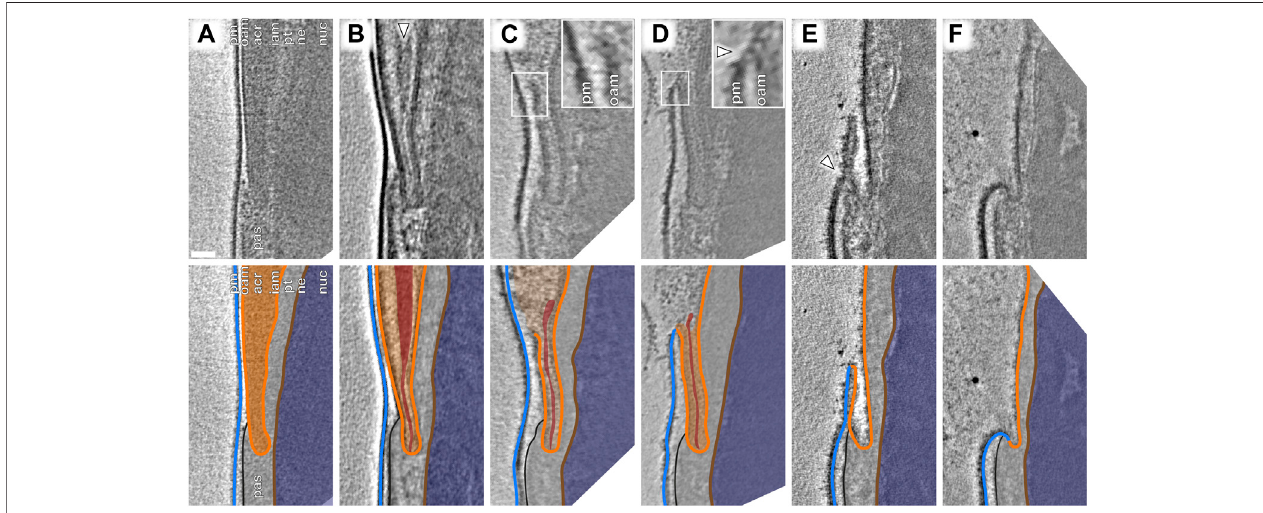
FIGURE 4 | An atypical membrane fi ssion – fusion pathway maintains cell integrity at the equatorial region. (A – F) Computational slices (top panels) and corresponding schematic annotations (bottom panels) of Volta phase plate cryotomograms of the equatorial region of sperm incubated for ∼ 2 h in capacitating media without (A – D) and with (E,F) subsequent ∼ 30-min ionophore stimulation. In (B) , the white arrowhead indicates condensed material at the core of the acrosome that is continuous with a thin streak of electron-dense material in the equatorial segment. In (C) , the inset shows the point of OAM rupture immediately anterior to the equatorial region. In (D) , the inset shows that the OAM has fused (white arrowhead) with the overlying PM at this location. Scale bar: 50 nm. Labels: pm, plasma membrane; oam, outer acrosomal membrane; acr, acrosome; iam. inner acrosomal membrane; pt, perinuclear theca; ne, nuclear envelope; nuc, nucleus; pas, post- acrosomal sheath. Color scheme: blue — plasma membrane, orange — outer and inner acrosomal membranes, red — condensed acrosomal material, light gray — perinuclear theca and post-acrosomal sheath, brown — nuclear envelope, dark blue —